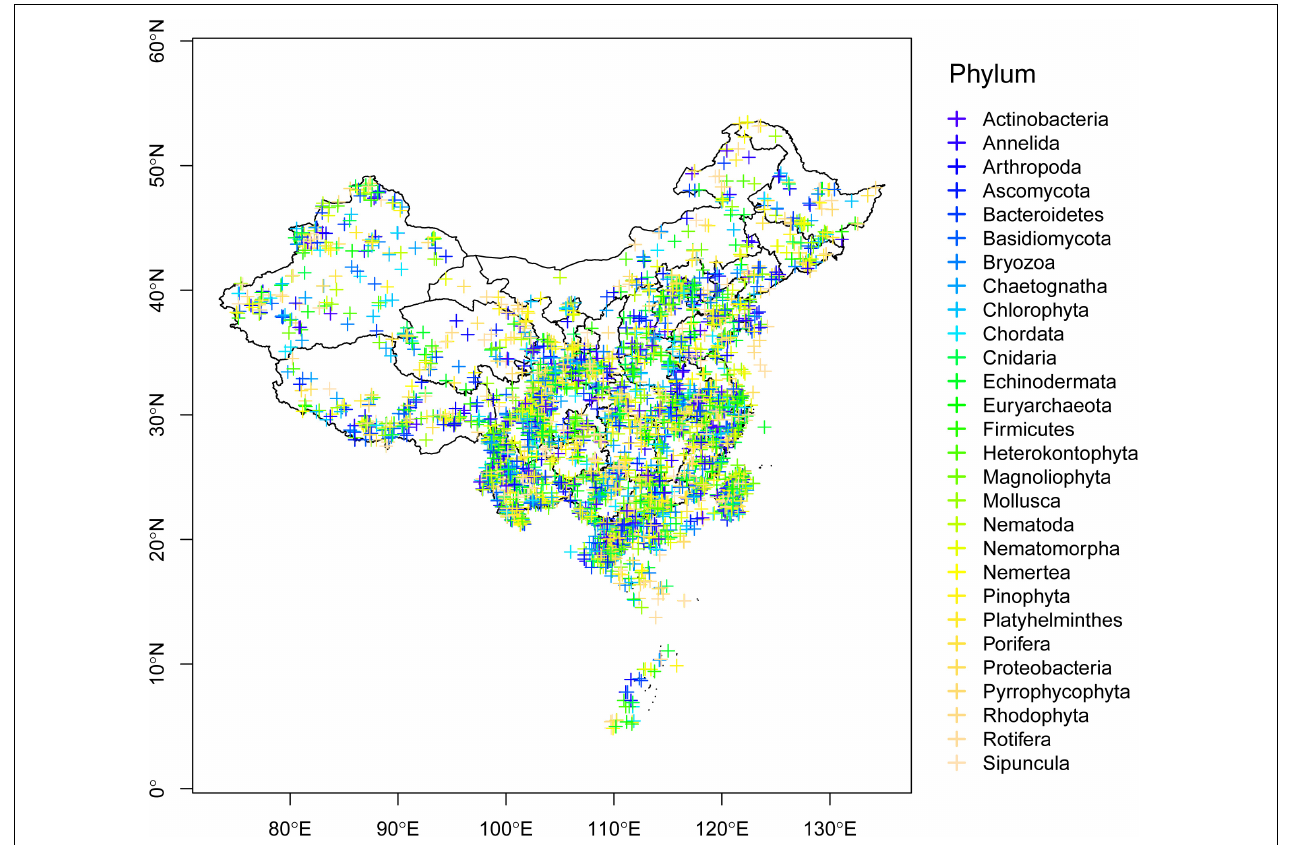
FIGURE 2 | Geographical distribution of barcodes in the BOLD system contributed by Chinese scientists, with samples collected in China. Phyla are denoted by different